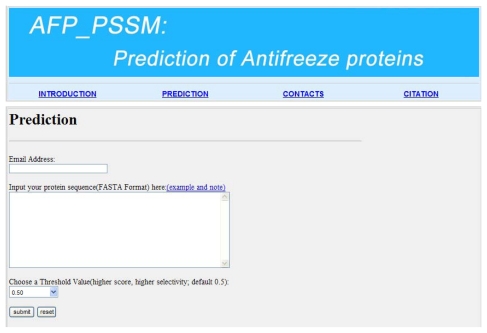
The top page of the AFP_PSSM web server [28].